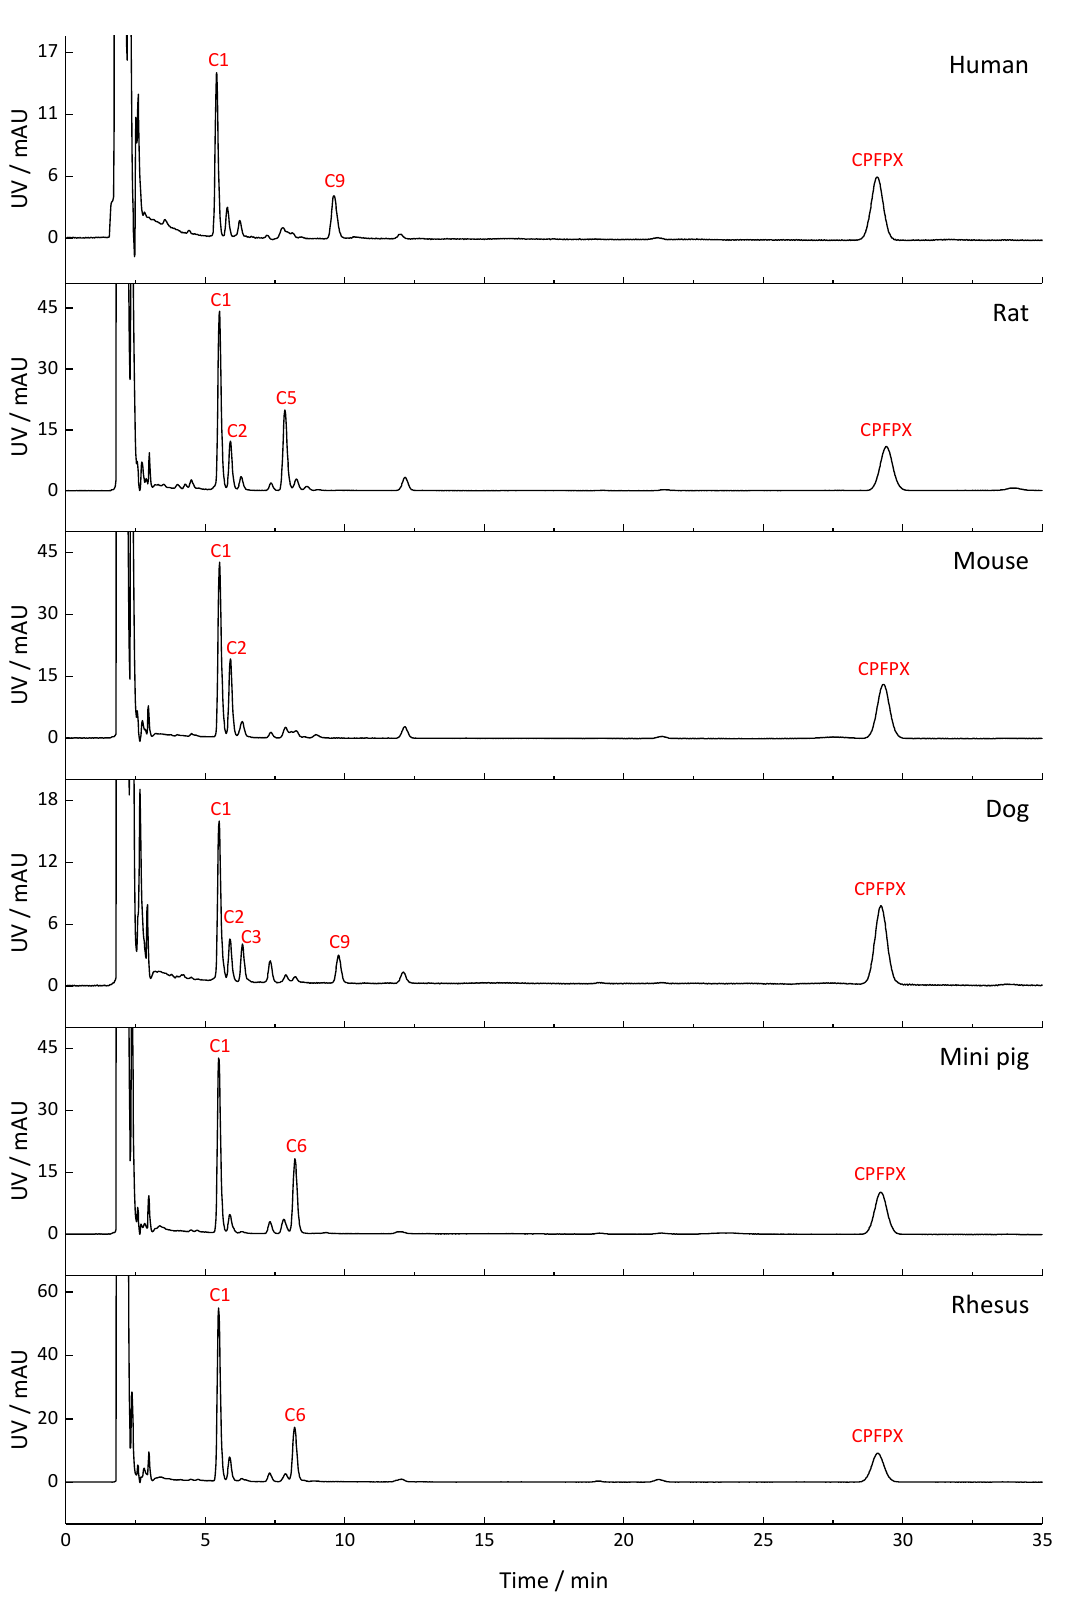
Figure 4. Metabolite profiles of CPFPX generated in liver microsomes from humans and different animal species. Detection wavelength was 275 nm. In the chromatograms, only metabolite peaks accounting for at least 10% of the total metabolite peak area are labeled. A comprehensive list of the detected metabolites can be found in Table 4.